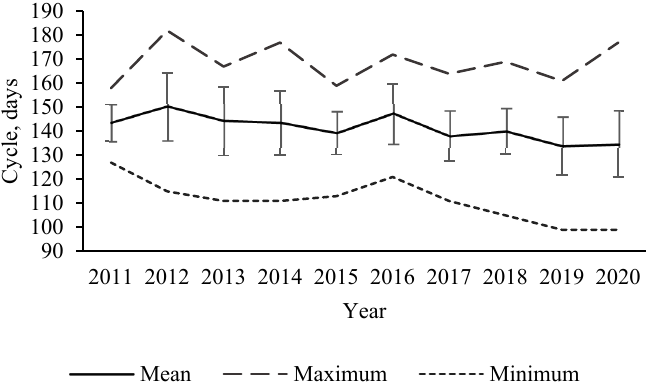
Figure 1. Cycle in days after sowing (DAS) of corn cultivated for silage production in ten summer crops (2011–2020) in the state of Paraná, Brazil. Maximum value, mean (±SD), and minimum value. In 2011, the crop showed the lowest standard deviation (SD) observed (7 days), the year in which the 30B39 hybrid was used in 71% of the farms visited. In this season, the average cycle was 144 days, ranging from 127 to 148 days, while the 30B39 hybrid cycle was 152 days, ranging from 131 days in Candói to 182 days in Guarapuava (1100 m alti ‐ tude). Table 3. Corn hybrids used in the state of Paraná, Brazil in crops cultivated for silage production in ten summer crops (2011–2020).